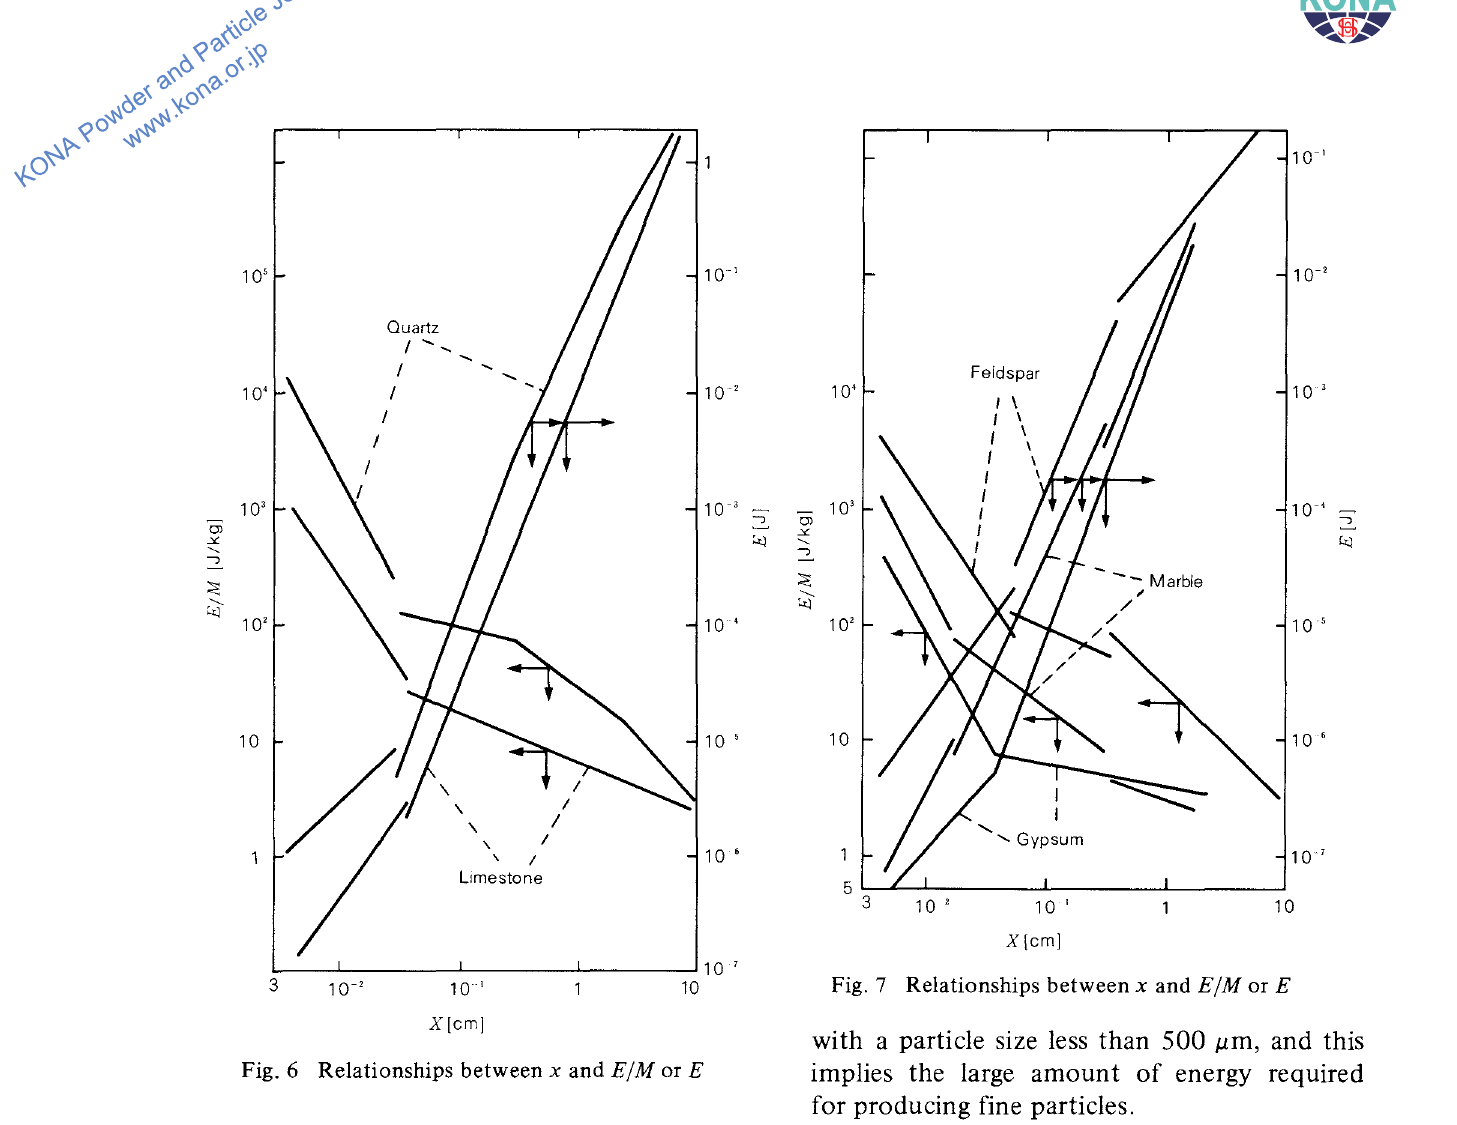
Fig. 6 Relationships between x and E/M orE